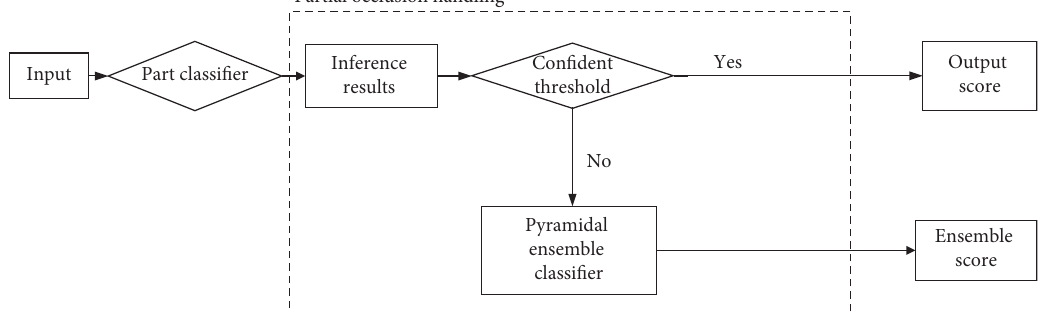
Figure 2: A proposed framework of the pyramid part-based model for occlusion